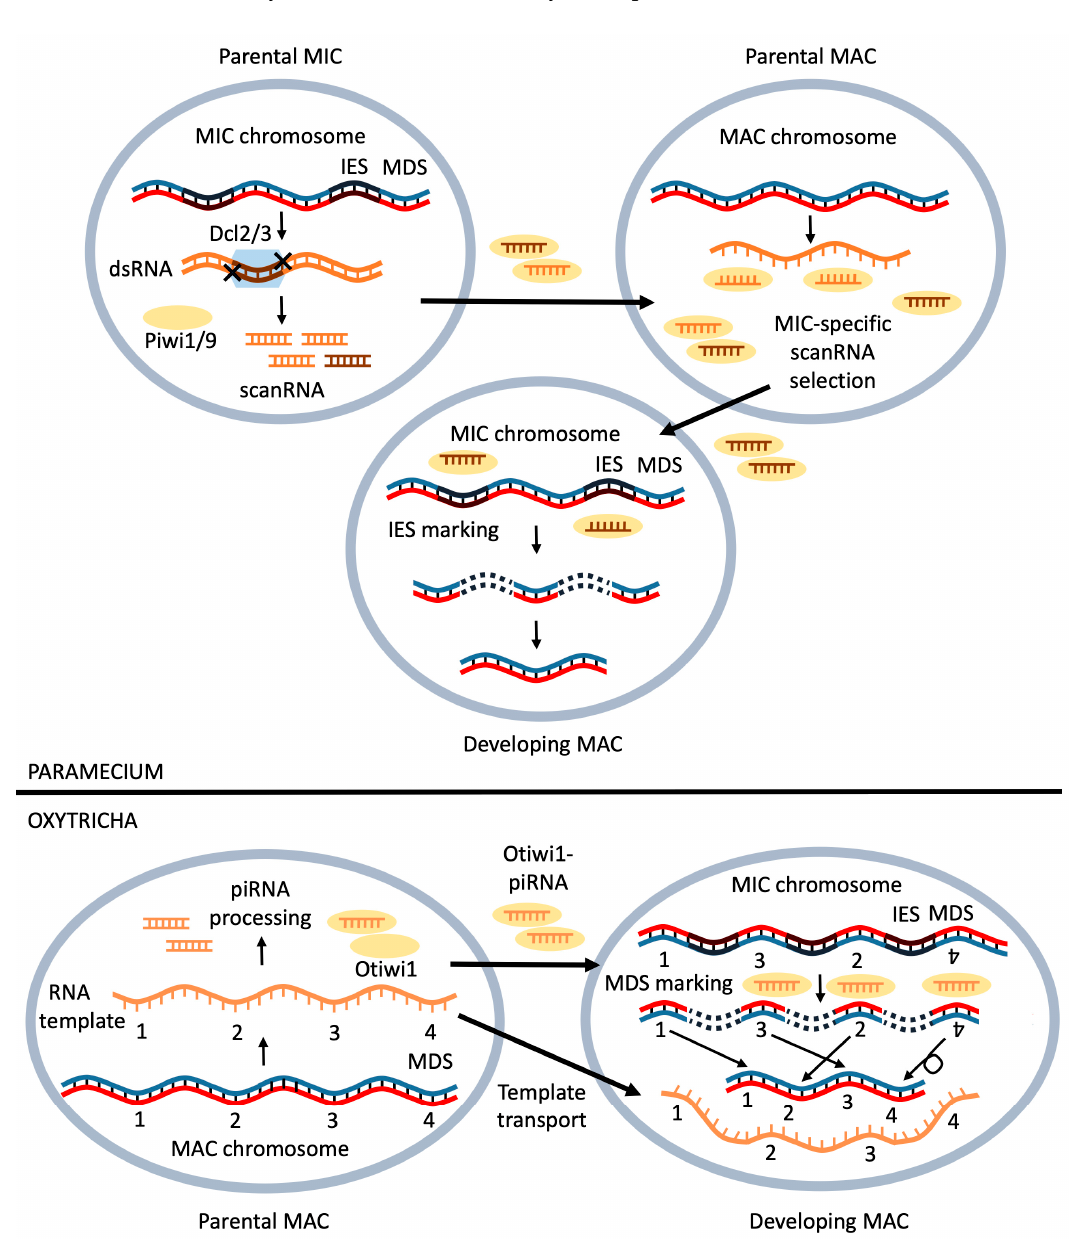
Figure 6. The participation of RNAs in the formation of a macronucleus (MAC) from a micronucleus (MIC) in ciliates Tetrahymena, Paramecium and Oxytricha trifallax . The upper part of the figure illustrates the role of scanning RNAs (scanRNAs) in Tetrahymena and Paramecium . MIC genome produces double-stranded RNA (dsRNA), which is processed into scanRNAs by Dicer-like proteins Dcl2/3. Piwi1/2 forms a complex with scanRNA, and together, they migrate into parental MAC. The scanRNAs bind complementarily to the macronucleus RNA, and after MIC-specific selection, only internally eliminated sequences (IES) are transported into developing MAC. Bellow, it is shown how RNAs direct genome rearrangement in Oxytricha trifallax . Otiwi1 binds to piwi-interacting RNA (piRNA), and Otiwi1–piRNA complex is transported into developing MAC. The Otiwi1-piRNA complex recognizes and marks macronuclear destined sequences (MDS) regions. RNA template helps to guide rearrangements. In the lower right illustration, segments 2 and 3 are switched, and segment 4 is inverted.